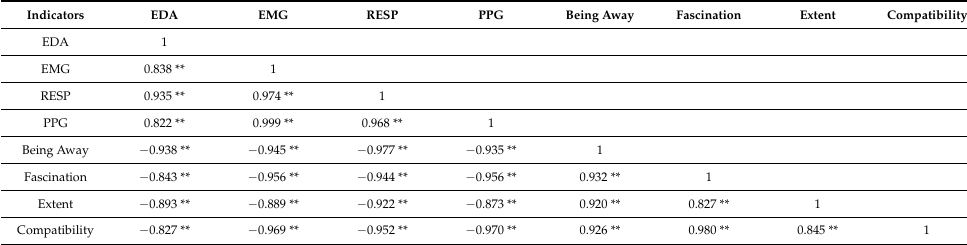
Table 5. Pearson correlations between stress recovery and attention